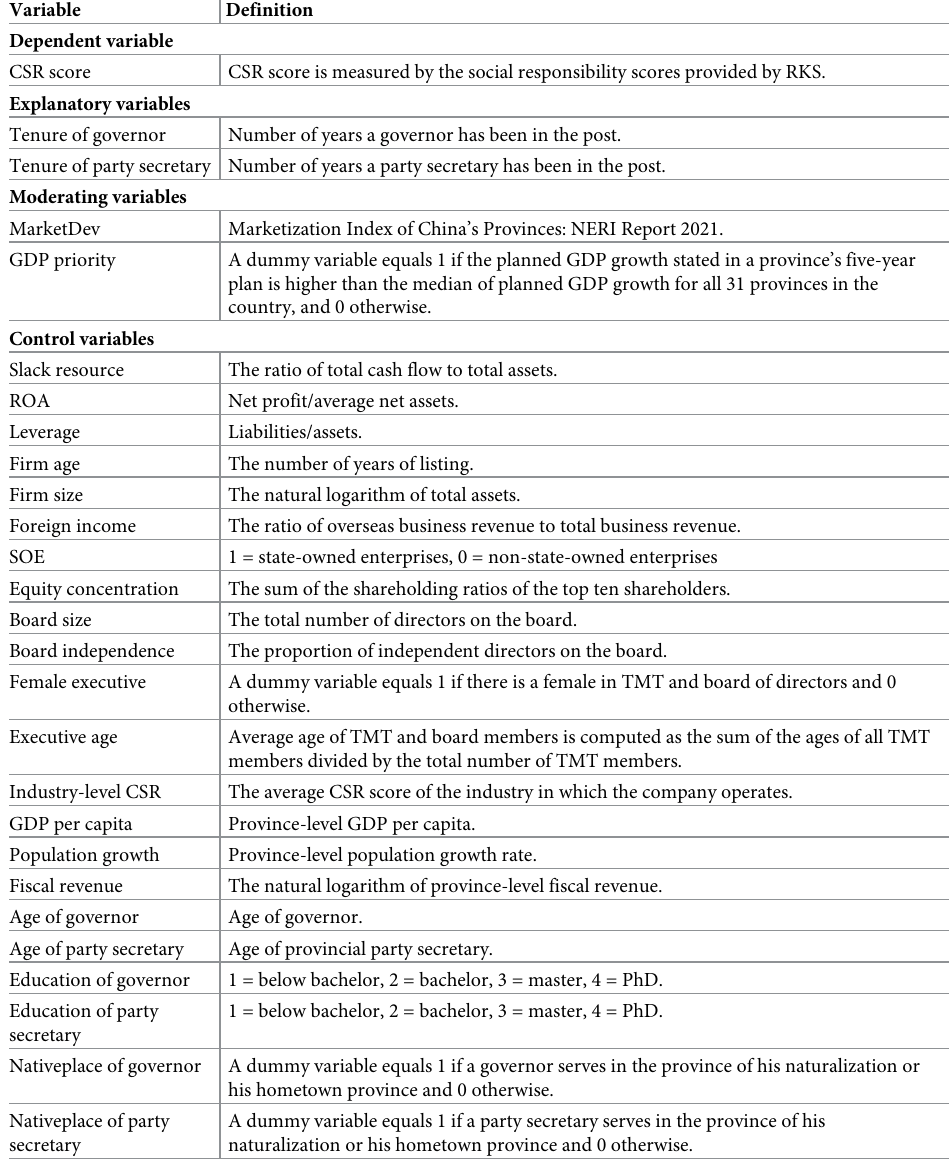
Table 1. Definitions of